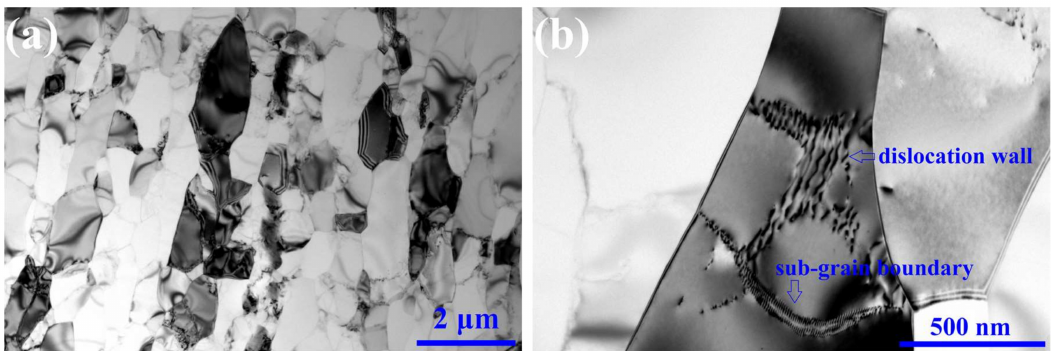
Figure 10. TEM micrographs of ECAPed sample: ( a ) grain size and morphology with lower magnification and ( b ) intragranular microstructure with higher